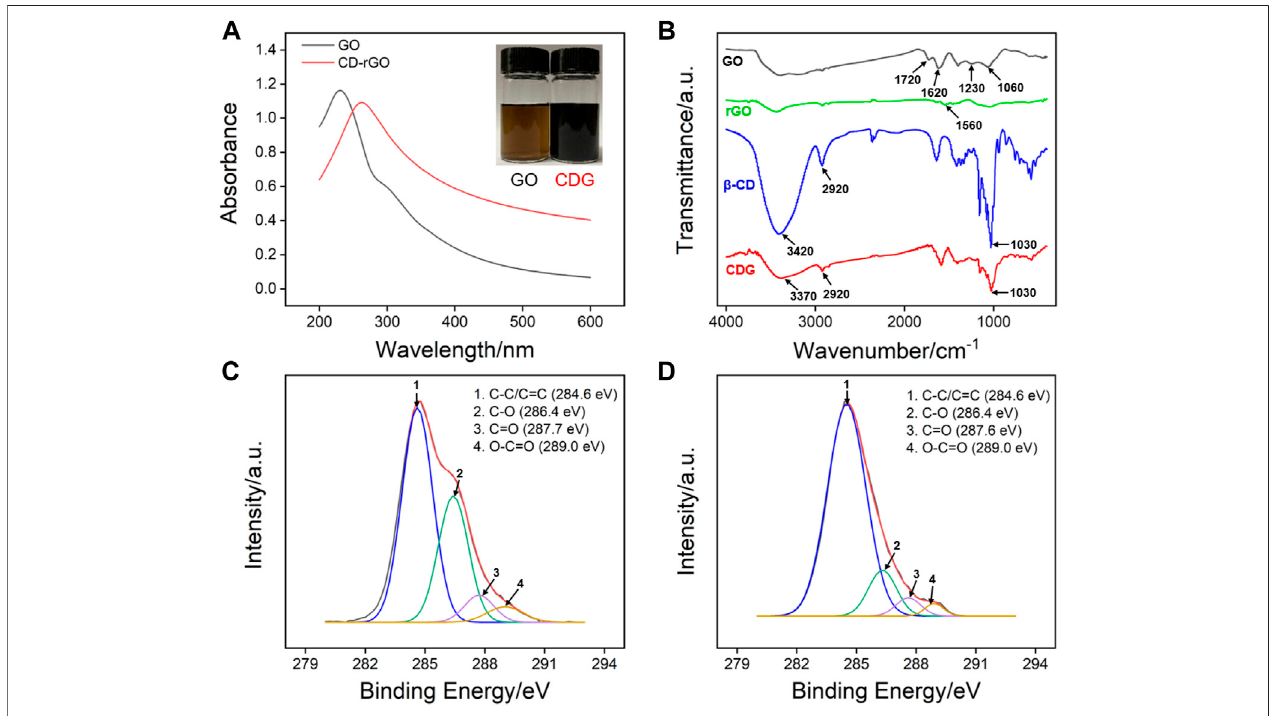
FIGURE2|(A) UV-visabsorption spectraofGOandCDG. (B) FT-IRspectraofGO,rGO, ß -CDandCDG. (C,D) high-resolution C1sXPSpro fi